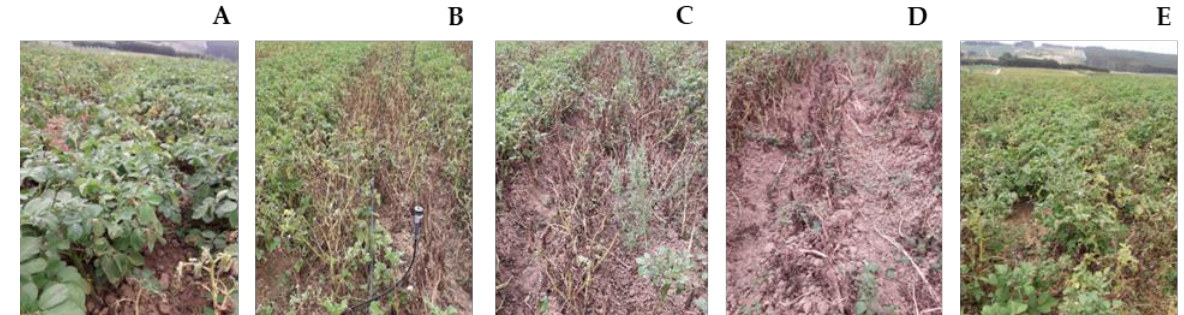
Figure 4. Production overview of S. tuberosum L. in Field B (Agria variety) after six foliar applications: ( A )—Control; ( B )—CaCl 2 12 kg∙ha −1 (12A); ( C )—CaCl 2 24 kg∙ha −1 (24A); ( D )—Ca-EDTA 12 kg∙ha −1 (12B); ( E )—Ca-EDTA 24 kg∙ha −1 (24B).